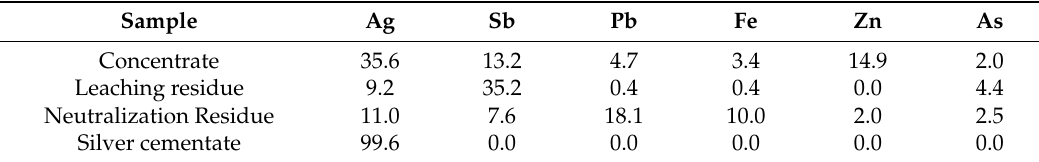
Table 9. Composition of input and output streams (wt. %).